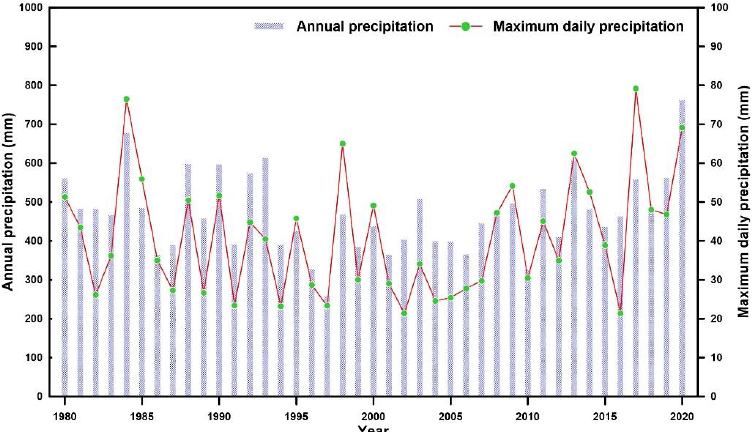
Figure 3. Geological setting of the study area. The geological map is derived from the local gov- ernment.